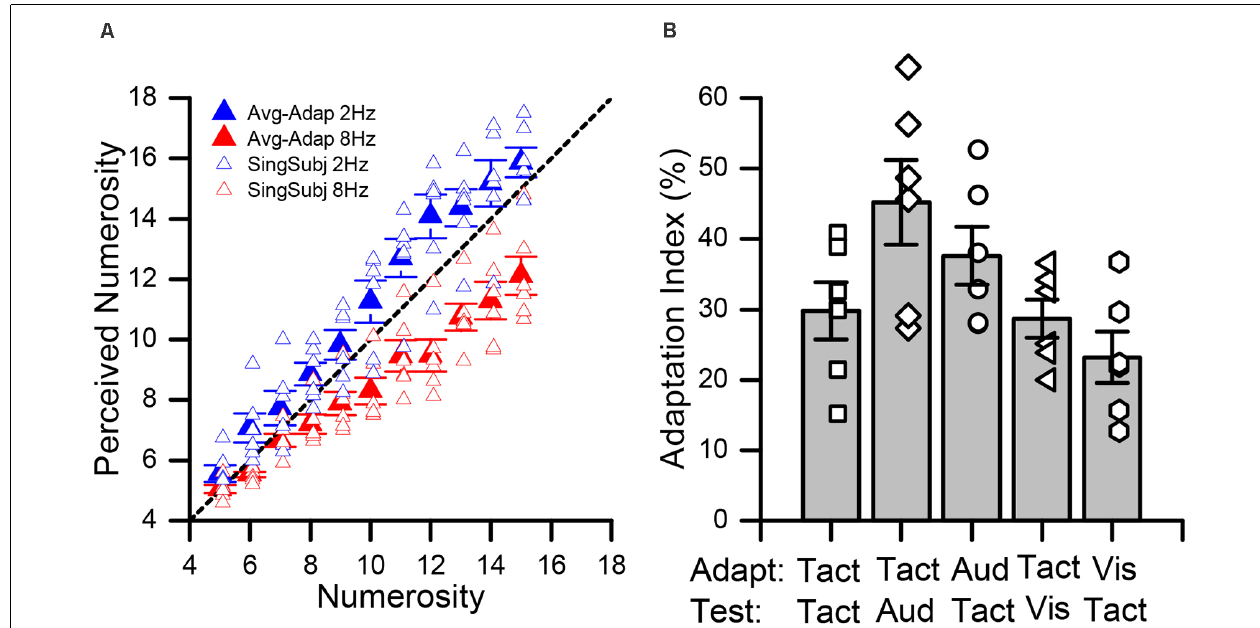
FIGURE 2 | Effect of adaptation in the tactile and cross-modal conditions. (A) Average numerical estimates for each numerosity (from 5 to 15), in the pure tactile (Tact-Tact) condition. Data relative to the low adaptation condition (2 Hz) are shown in blue whilst those for high adaptation (8 Hz) in red. Individual data (averaged over trials) are shown by the empty symbols whilst bold filled symbols indicate averages across participants. (B) Average adaptation effect indexes (AIs) across the different conditions. The empty data points show the adaptation effect for all participants. Error bars represent